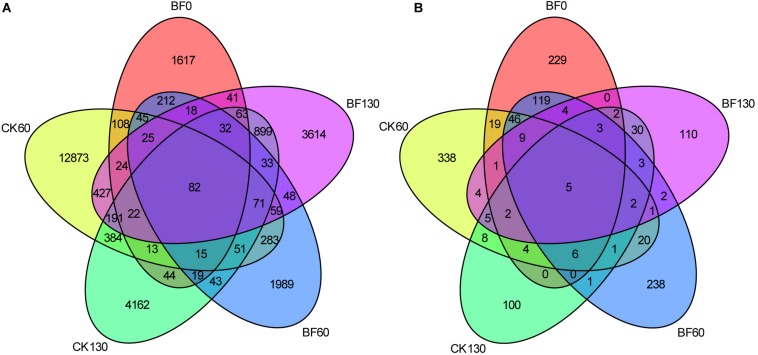
Venn diagram of unique and shared operational taxonomic units (OTUs) among samples. Numbers indicate the number of unique and shared bacterial (A) and fungal OTUs (B).